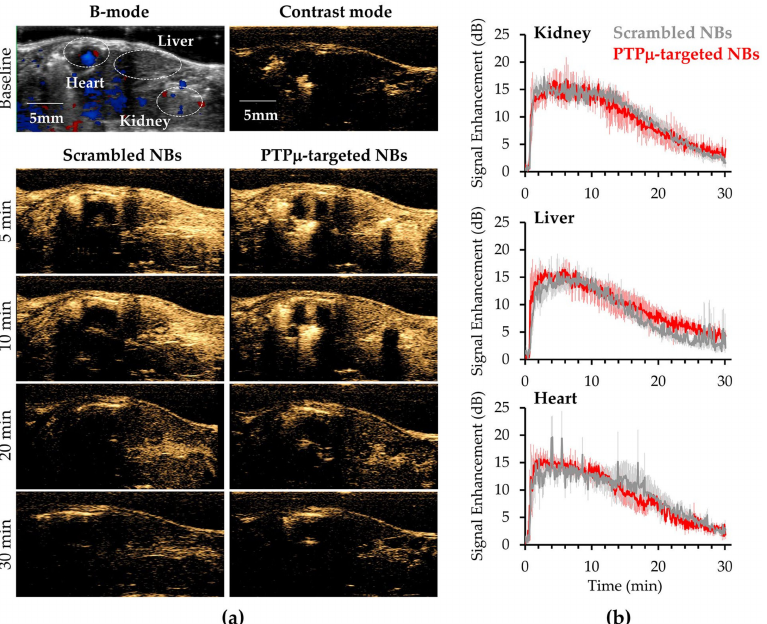
Figure 2. Ultrasound imaging of non-tumor bearing control mice treated with Scrambled and PTP µ - targeted NBs. ( a ) Representative images of non-tumor bearing control mice administered Scrambled-NBs and PTP µ -targeted NBs. The two NB types show similar enhancement of the heart, liver and kidneys at the times indicated. Top row shows a B-mode baseline image used for positioning (left) and a baseline contrast harmonic image (CHI) (right). Lower panels show heart, liver and kidney enhancement by the different NBs at the indicated times. ( b ) PTP µ -targeted and non-targeted NB (Scrambled-NB) show similar kinetics of signal enhancement and gradual clearance in kidney, liver and heart in non-tumor bearing mice. Images of the three organs were collected simultaneously over 30 min in mice ( N = 3) receiving both types of NB. Mean signal intensity ± standard error are plotted for each organ